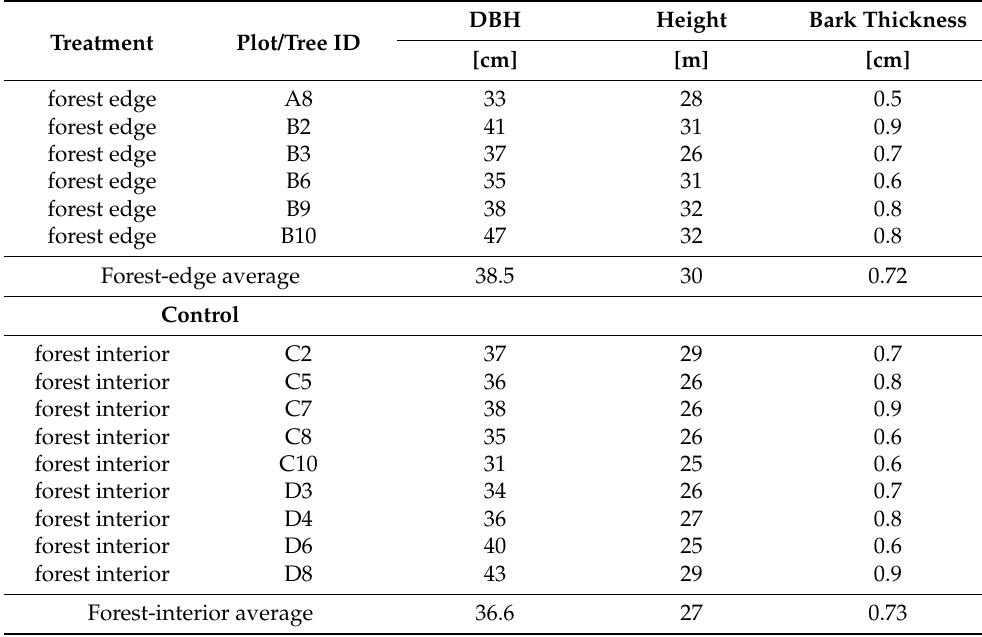
Figure 1. Location of the study site and sub-plots. The clearcutting of the forest edges can be seen in the right photograph. Table 1. Stand characteristics of the experimental plots.